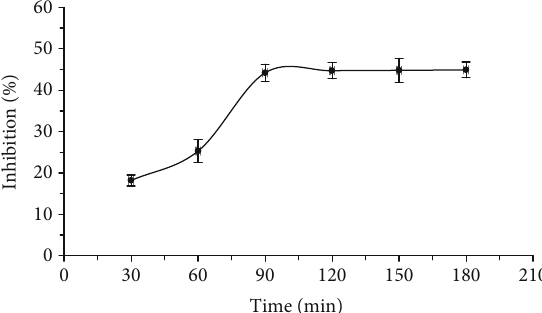
Figure 2: The in fl uence of the competitive reaction time on sulfadiazine inhibition. (Figure S4). After shaking for 60 min, high absorption capacity of 30.53 mg/g for the MIP was obtained, which was 74.45% of the maximum adsorption capacity. The adsorption almost approached equilibrium within 120 min.